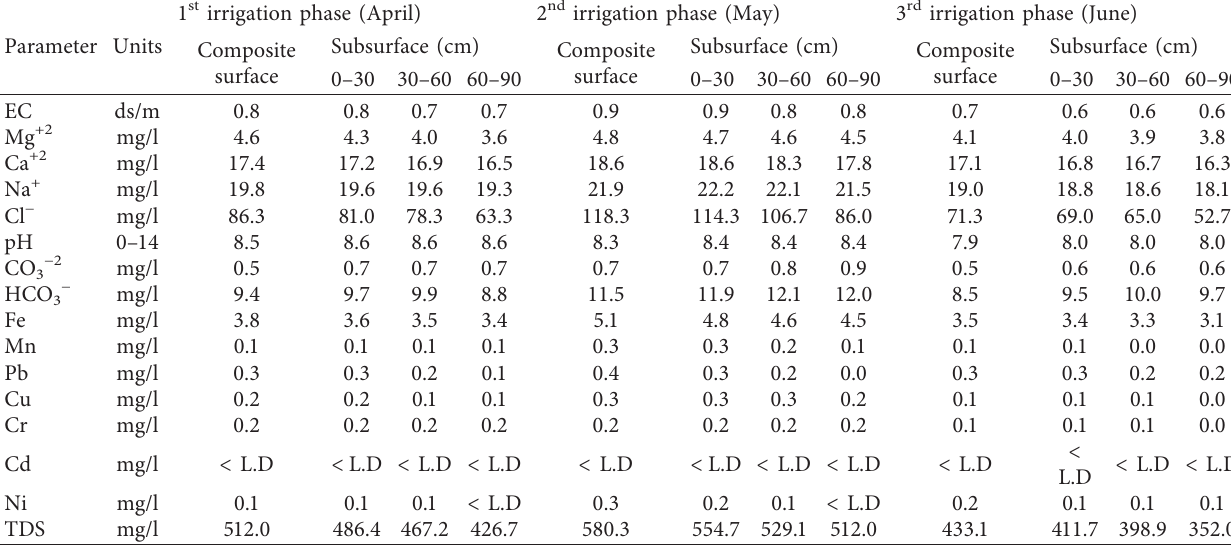
Table 6: The characteristics of downstream Borkena irrigated farm soil during the dry and wet period. Parameter Units